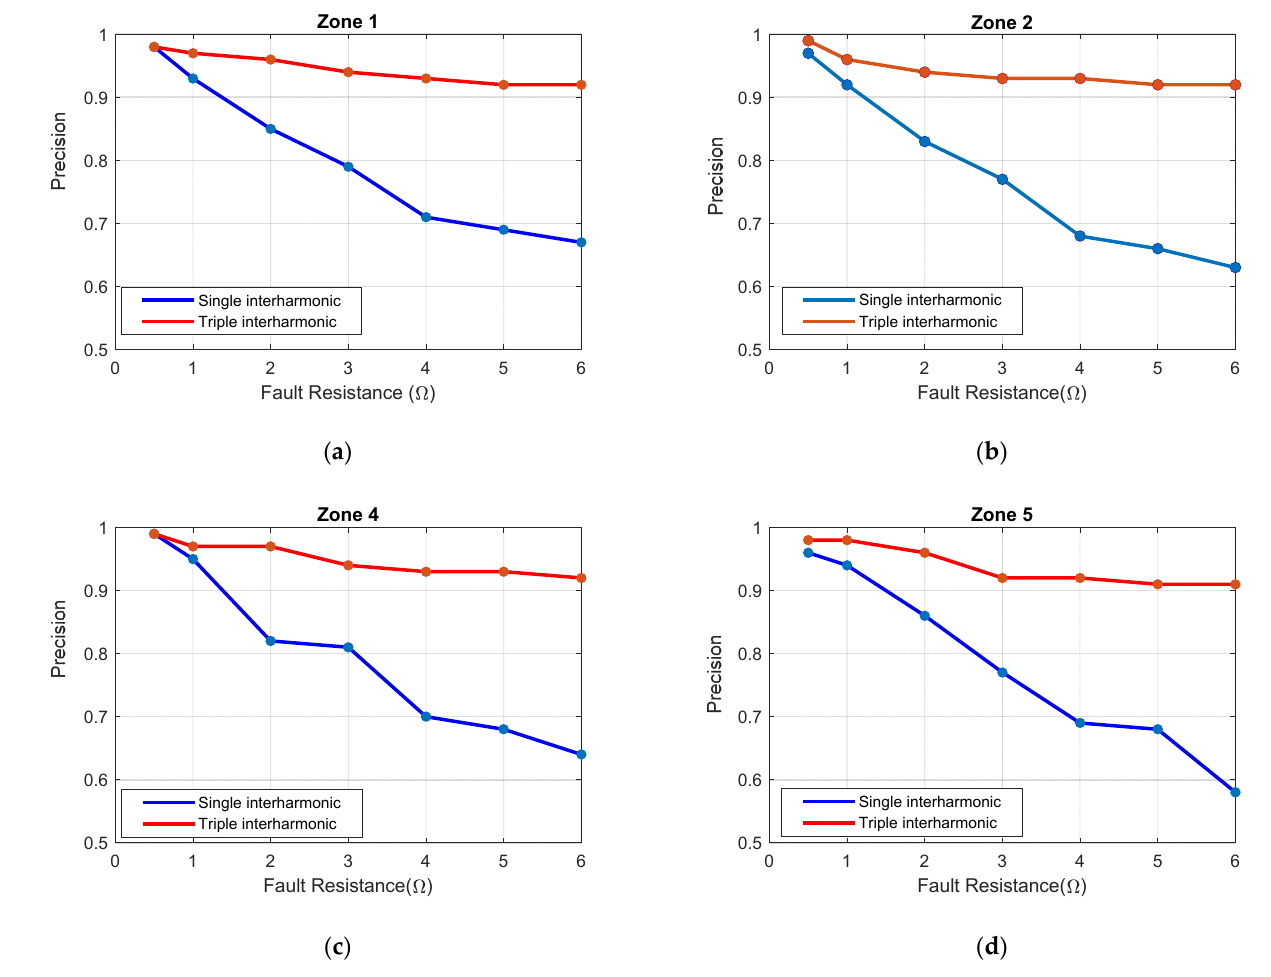
Figure 8. Precision of fault location detection with single and triple interharmonic injection. ( a ) zone 1, ( b ) zone 2, ( c ) zone 4, and ( d ) zone 5.